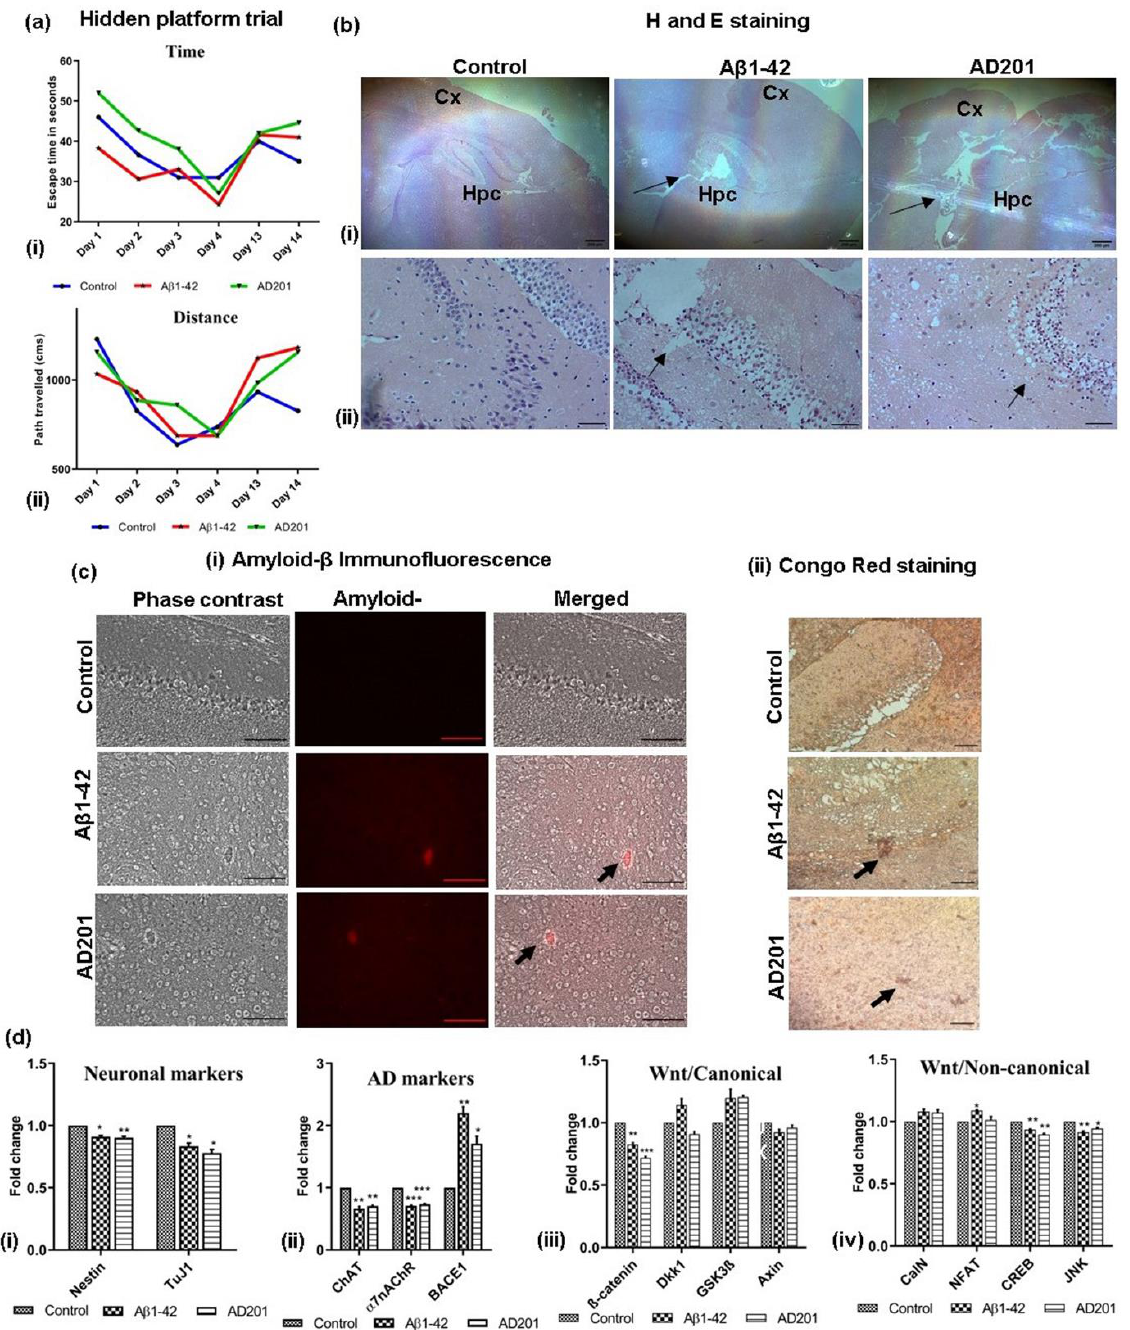
Figure 6. In vivo mouse AD model: comparison of Aβ model with Wnt antagonist, AD201 model. ( a ) Changes in ( i ) escape time and ( ii ) distance traveled by the mice among different groups to reach the hidden platform, ( b ) microscopic images of H and E-stained brain sections showing hippocampal and cortex regions (sham control, Aβ 1 – 42 and AD201) at ( i ) 4× (scalebar = 200 µm) and ( ii ) 40× magnification (scalebar = 50 µm); arrows indicating loss of neurons, Hpc-Hippocampus, Cx-Cortex. ( c ) Determination of Aβ 1 – 42 deposition in brain sections by ( i ) immunofluorescence and ( ii ) Congo red staining the Aβ 1 – 42 deposits (Aβ accumulation indicated b y arrow, 20× magnification, scalebar = 100 µm). ( d ) Gene expression analysis by qRT-PCR performed for ( i ) neuronal markers: Nestin, tuj1, ( ii ) AD- associated markers: ChAT, α7nAChR and BACE1, ( iii ) Wnt/canonical pathway genes- β - catenin, Dkk1, GSK3β and Axin; ( iv ) Wnt/non-canonical pathway genes-CalN, NFAT, CREB and JNK. Data are represented as mean with SEM ( n = 3), * p < 0.05, ** p < 0.01 *** p < 0.001.